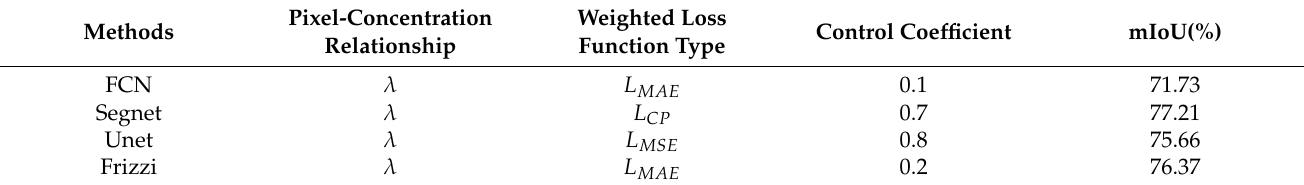
Table 5. Determination of experimental parameters for different segmentation methods.